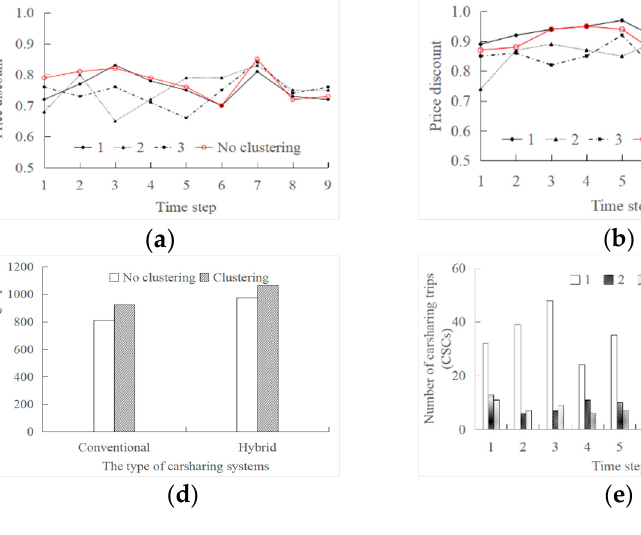
Figure 4. Performances of each user cluster at each time step with or without the TPS. ( a ) Price discount for the CSC users, ( b ) Price discount for the SAV users, ( c ) Number of carsharing trips, ( d ) Total number of carsharing trips, ( e ) Number of CSC trips, ( f ) Number of SAV trips. The red line means the price discount given to all users in the hybrid carsharing